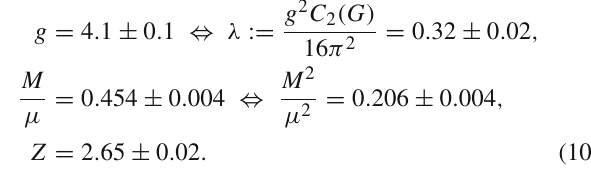
Fig. 4 RG flows in the parameter space ( ν := μ 2 / M 2 , ˜ g 2 := g 2 C 2 ( G ) of the four-dimensional massive Yang–Mills model. The arrows indi- cate the flow towards the infrared. Trajectories which connect to the ultraviolet Gaussian fixed point ( ∞ , 0 ) are separated in two classes: those which end at a Landau pole (purple dot-dash line) and those which are infrared safe, corresponding to decoupling solutions (blue dotted line) for the propagators. These are separated by a critical tra- jectory (green broken line) which relates the Gaussian fixed point to a nontrivial infrared fixed point (black dot) at finite, nonzero values of ν and ˜ g 2 and corresponds to a scaling solution for the correlators. We also show (red solid line) the trajectory which describes lattice results for the SU(3) theory